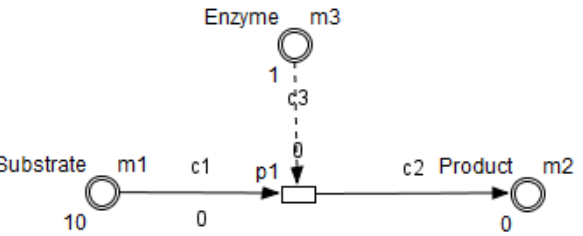
Figure 4. Test connector standing for enzyme catalysis and normal connector for protein production.